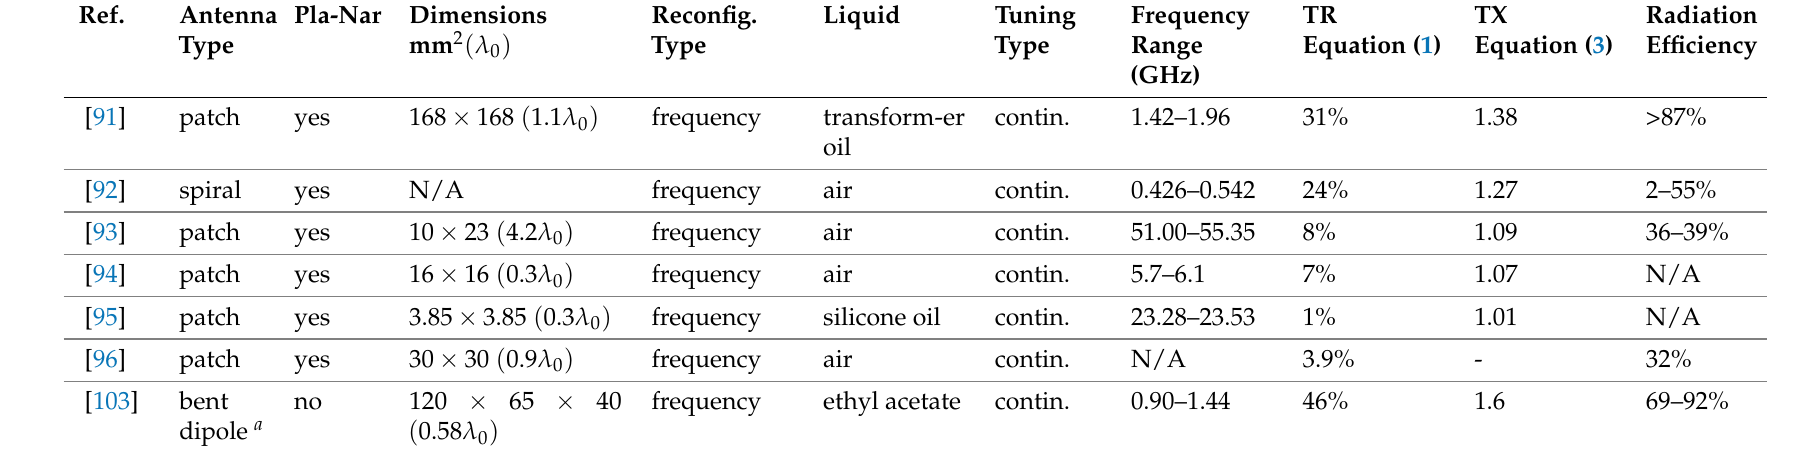
Table 6. Planar antennas with substrate